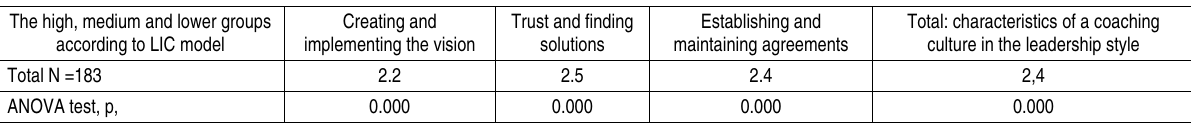
Table 8 (cont.). Characteristics of a coaching culture in the leadership style (based on the 3C model) in high, medium and low groups, according to the LIC model, in 2015 The high, medium and lower groups Creating and according to LIC model implementing the